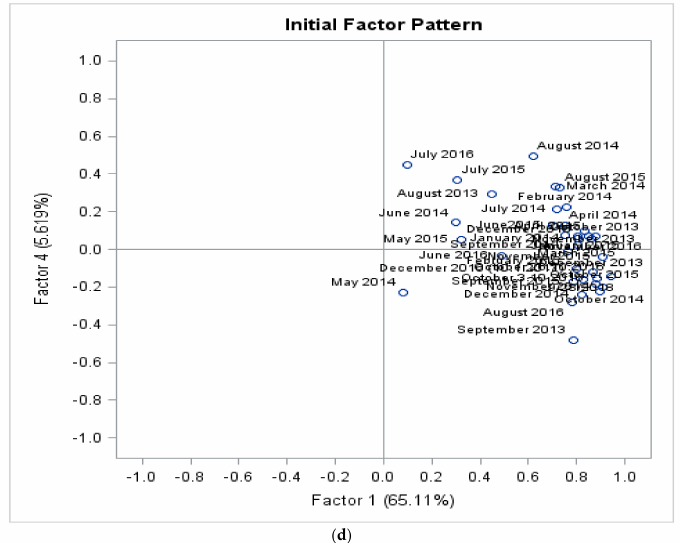
Figure 17. Four score plots built for five factor combinations at the Liito-oravankatu site. ( a ) Factor 2